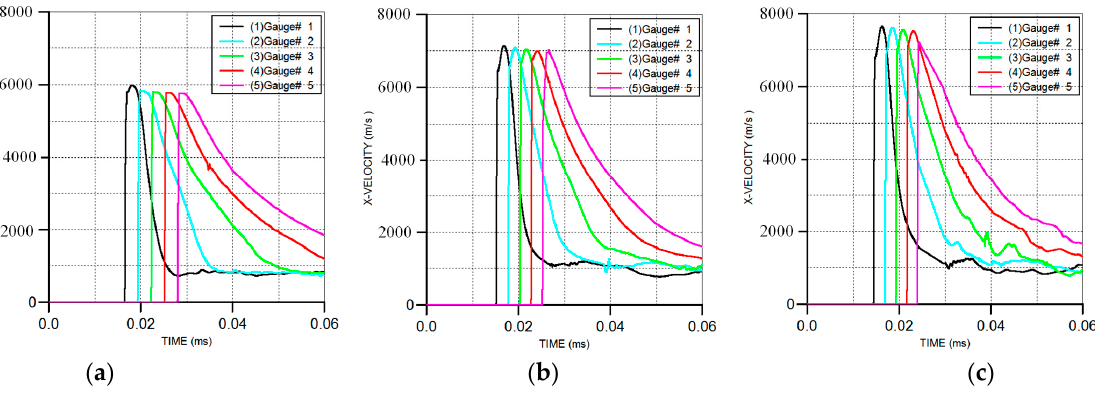
Figure 9. Velocity–time histories of composite jets at gauges #1~#5: ( a ) reactive material–Cu jet; ( b ) reactive material–Ti jet; ( c ) reactive material–Al jet.